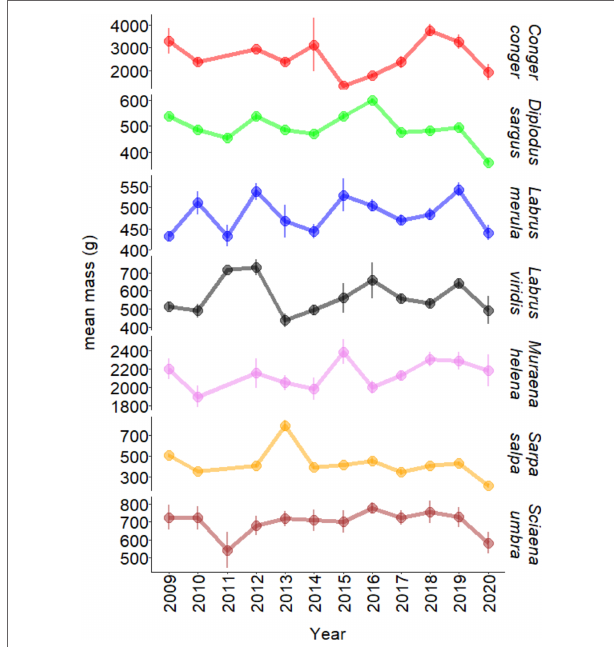
FIGURE 4 | The temporal trends of the average size of individuals of the most representative species caught during Italian marine spearfishing tournaments from 2009 to 2020. Mean values are showed with points and vertical lines indicate the standard error (N C. conger = 101; N D. sargus = 4286; N L. merula = 1018; N L. viridis = 443; N M. Helena = 362; N S. salpa = 368; N S. umbra = 759).